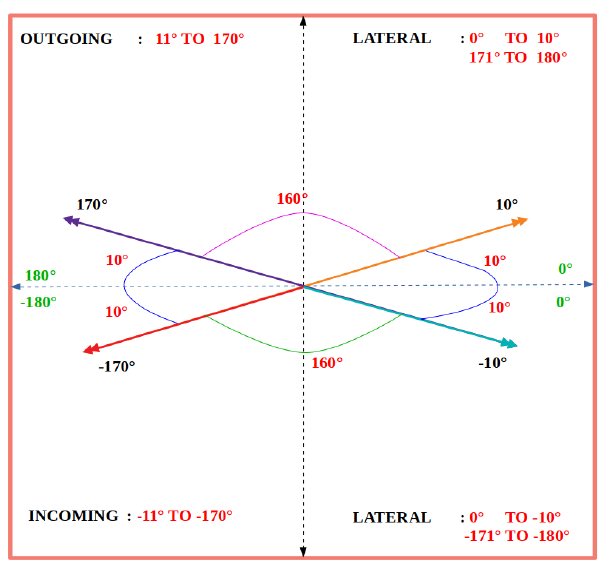
Figure 4. Degree ranges used to classify DPIV vectors as lateral, incoming, and outgoing.